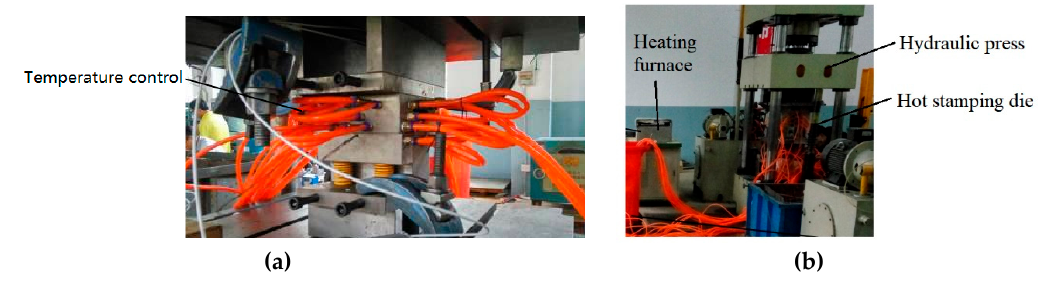
Figure 10. Friction coefficient curve under different loads and function fitting curve: ( a ) Warming stamping mold; ( b ) Test device for hot stamping U-shaped parts.